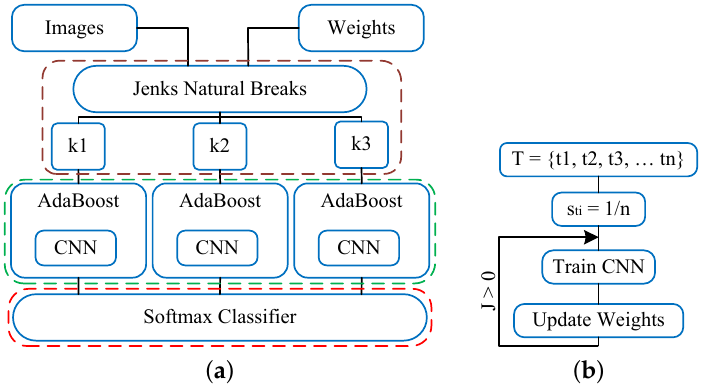
Figure 4. A stack based sequential description of the proposed approach: ( a ) A progressive coarse to fine classification based approach, and ( b ) AdaBoost CNN optimisation for fine classification of fruit and